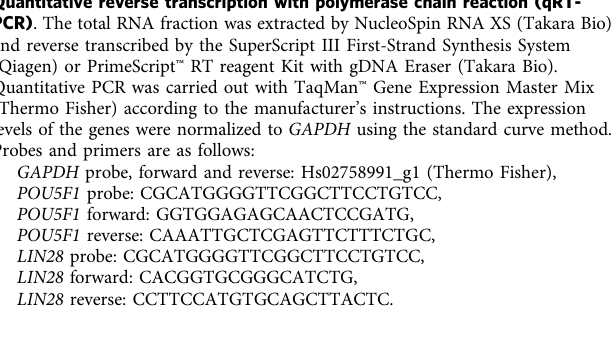
LIN28 reverse: CCTTCCATGTGCAGCTTACTC.